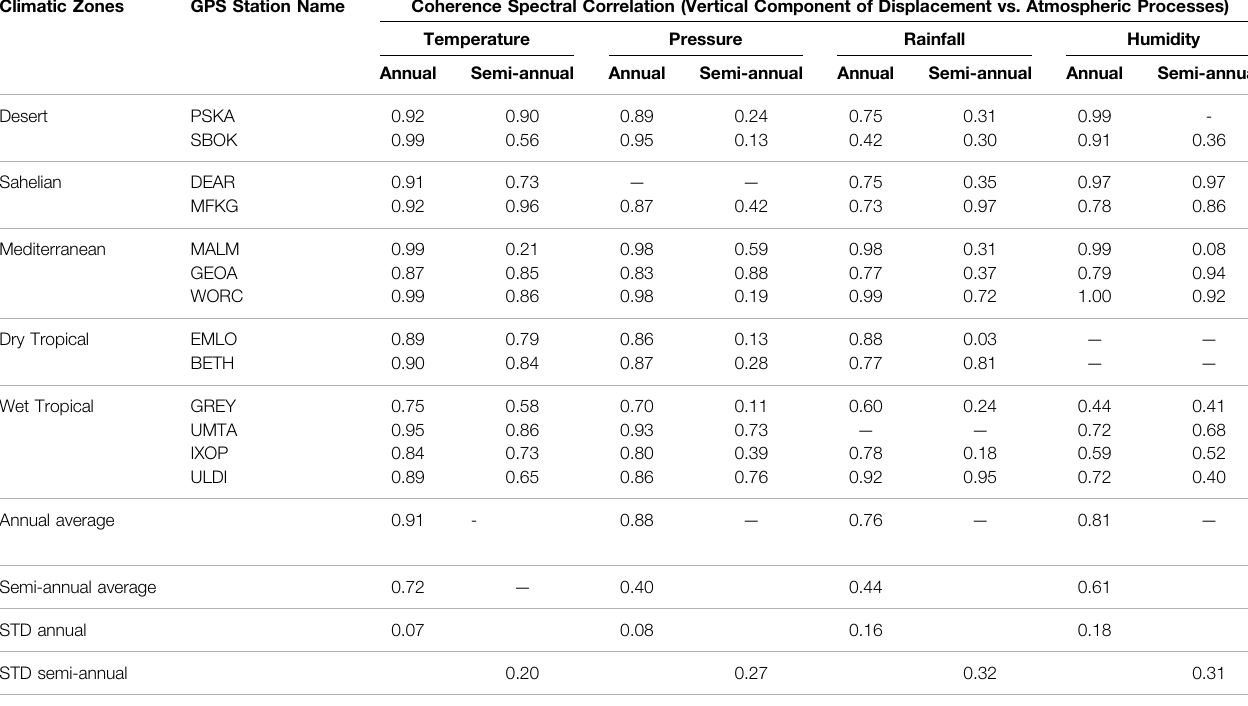
TABLE 4 | Coherence correlation strength of displacement vs. meteorological (average temperature, pressure, rainfall, and humidity) processes. Climatic Zones GPS Station Name Coherence Spectral Correlation (Vertical Component of Displacement vs. Atmospheric Processes)